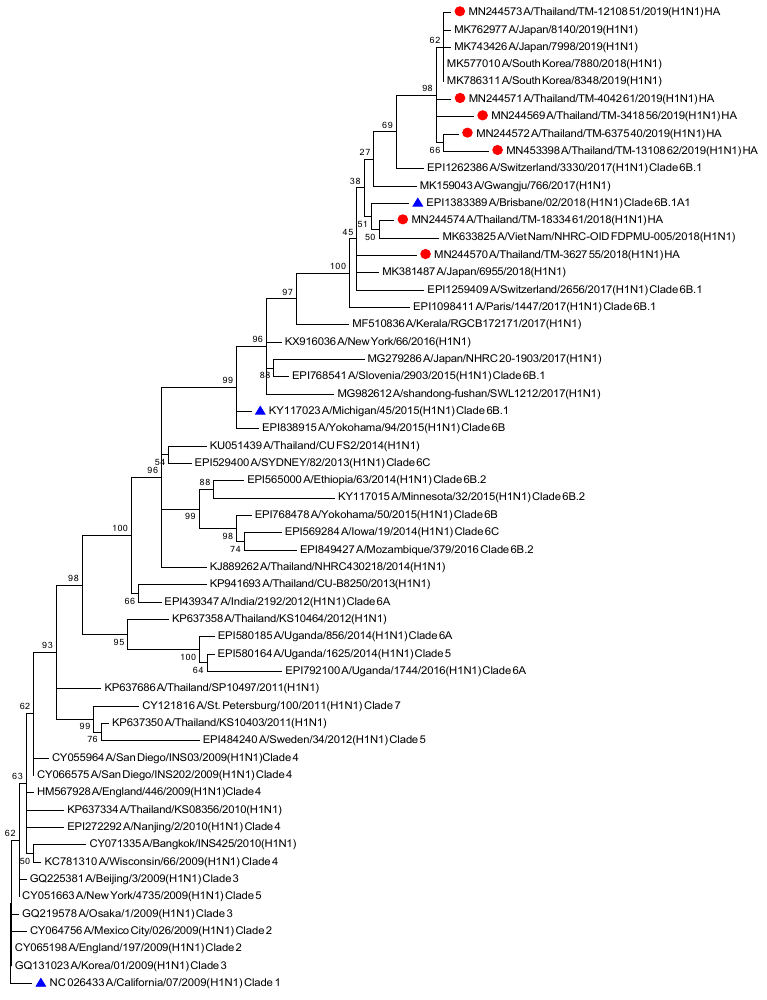
Figure 1. Phylogenetic tree of concatenate from all 8 genes of influenza A/H1N1 Thai strains was inferred by using the Maximum Likelihood method based on the Tamura 3-parameter model. Red circles indicate A/H1N1 Thai isolates and blue triangles indicate A/H1N1 vaccine